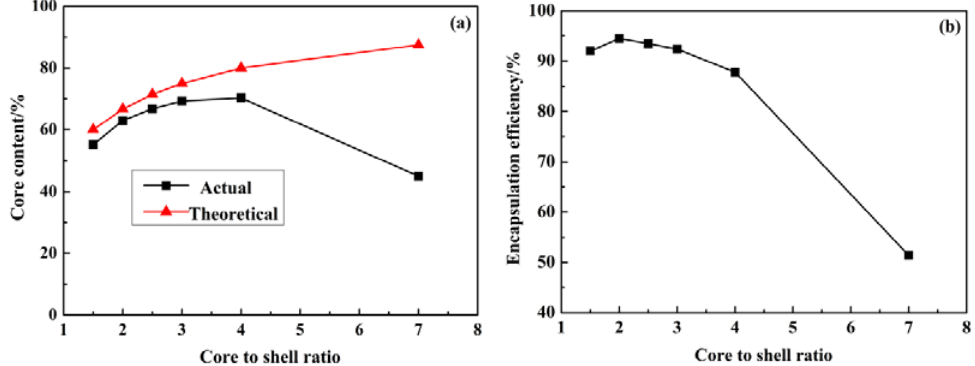
Figure 2. Influence of core/shell ratio on ( a ) core content and ( b ) encapsulation efficiency of Mi- croPCMs.